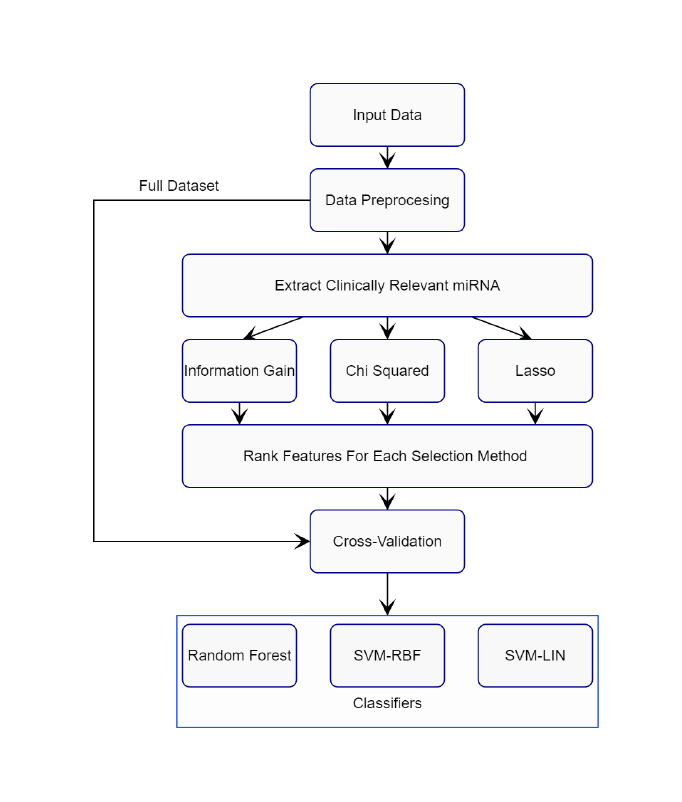
Figure 1. Schematics for Cancer Detection with Machine Learning.